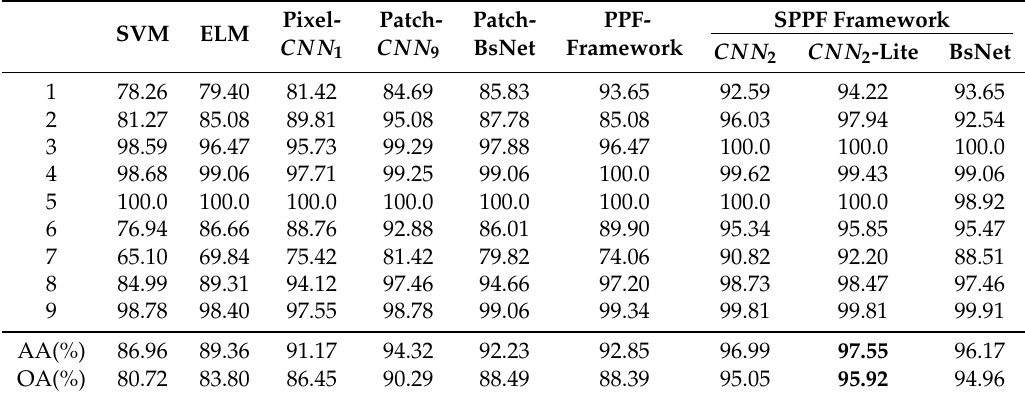
Table 8. Classification results on the Indian Pines dataset (accuracy shown in percentage).